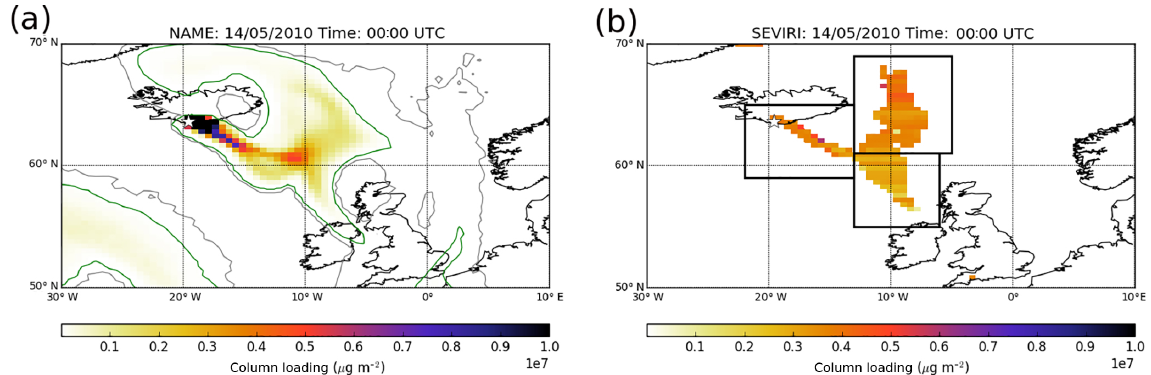
Figure 2. (a) Simulated ash column loading at 00:00UTC on 14 May 2010 using parameters near the default values. (b) SEVIRI satellite retrieved ash column loading also at 00:00UTC on 14 May 2010. The black boxes denote the regions over which average ash column loading is being emulated for this hour. In panel (a) column loadings of 20000 and 2000µgm − 2 are shown by the green and grey contours,